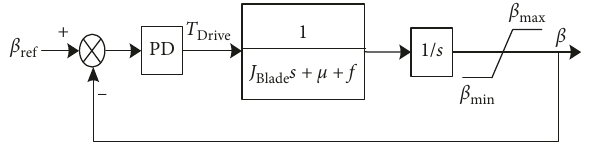
Figure 8: Blade pitch actuator dynamic.